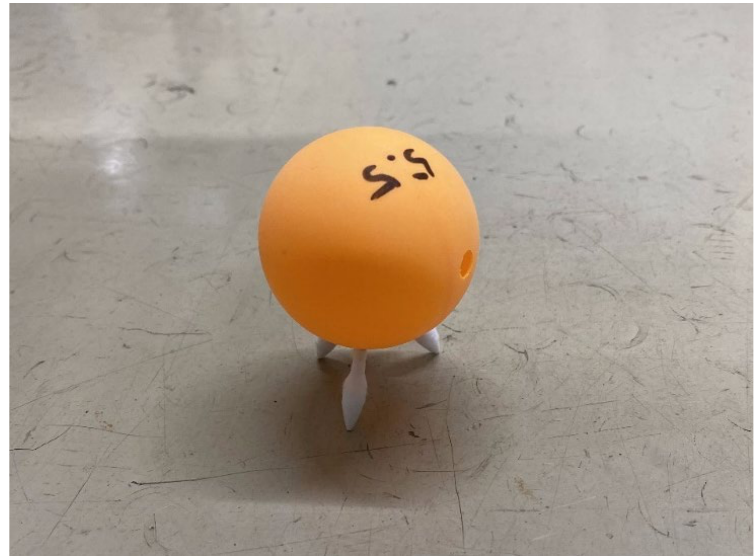
Figure 7. Appearance of a ball with a fine-tipped cotton swab (The diameter of the ball is 44 mm. The cotton swab length is 20 mm. Its weight is 2.7 g.).